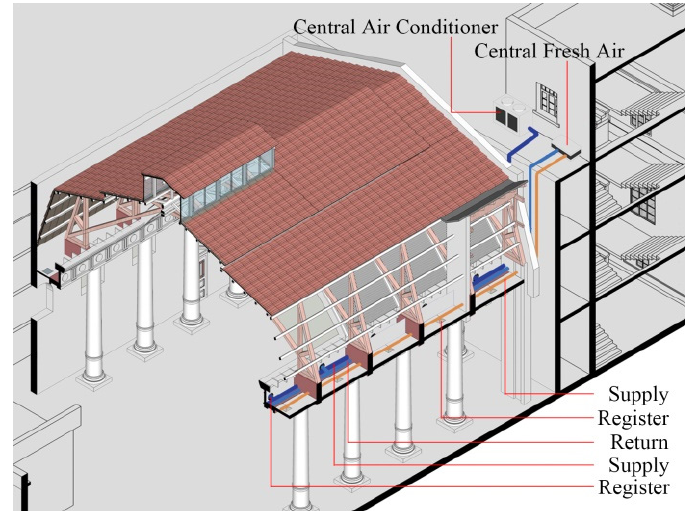
Figure 24. Feasibility analysis of equipment